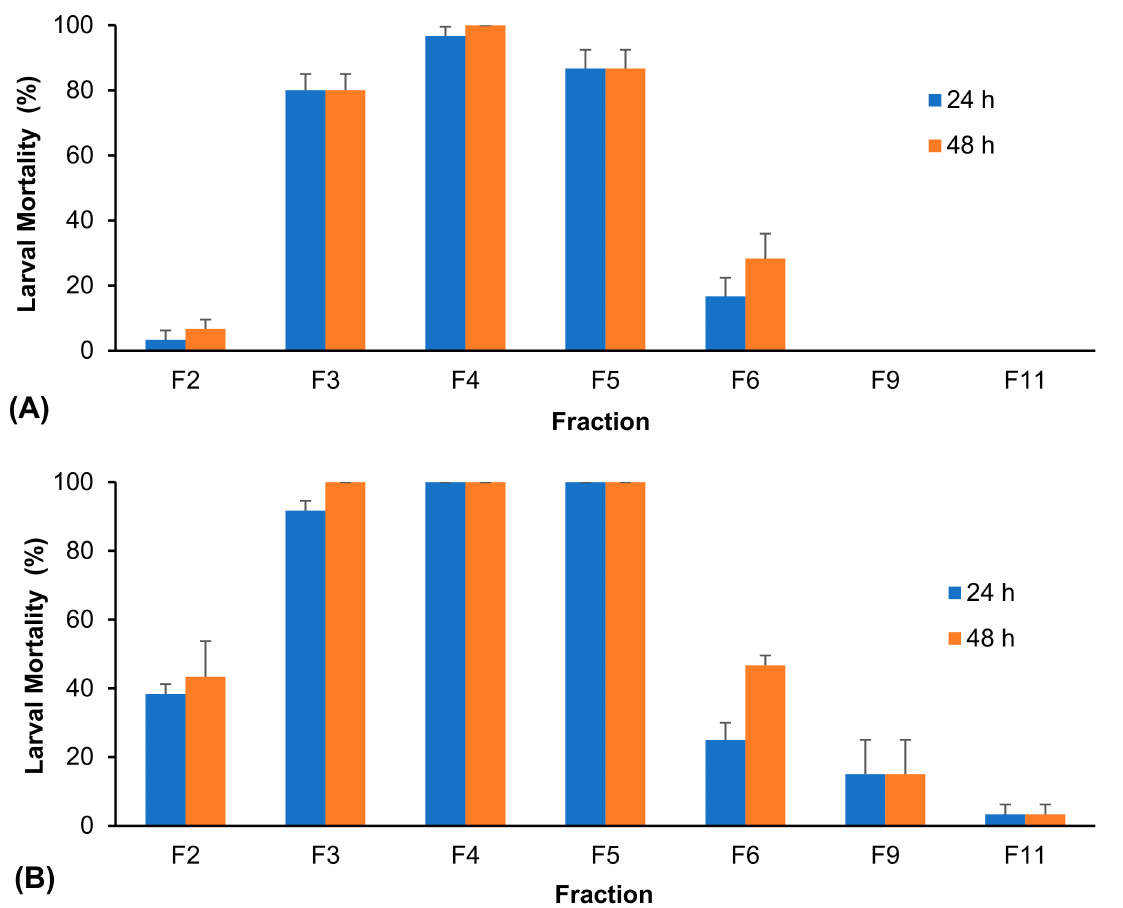
Figure 4. Percentage of mortality of third instar larvae of Ae. albopictus treated with fractions of the hexane extract of O. basilicum leaves for 24 and 48 h at 12.5 µ g/mL ( A ) and 25.0 µ g/mL ( B ). The fractions were eluted with different compositions of hexane and/or acetone. The percentage of mortality for each fraction is shown as mean ± standard deviation of